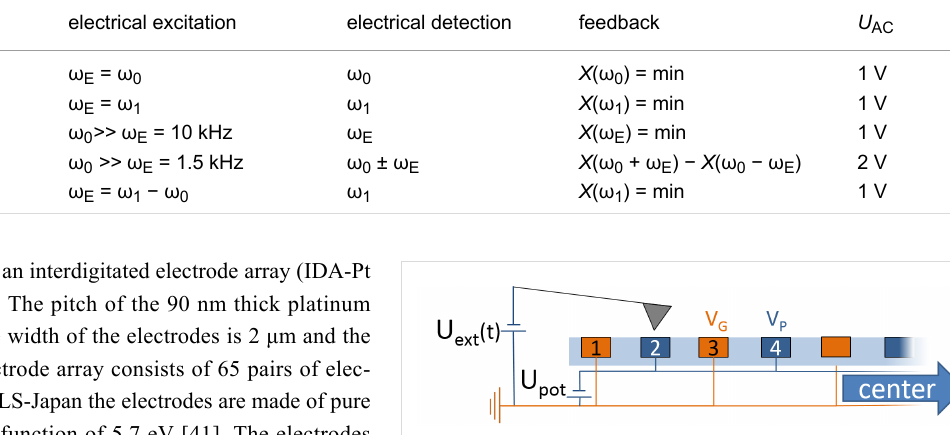
Table 1: Overview of methods and parameters, topography carrier in all cases is the first eigenmode of the cantilever ω t = ω 0 . ω 1 represents the second eigenmode of the cantilever. Method